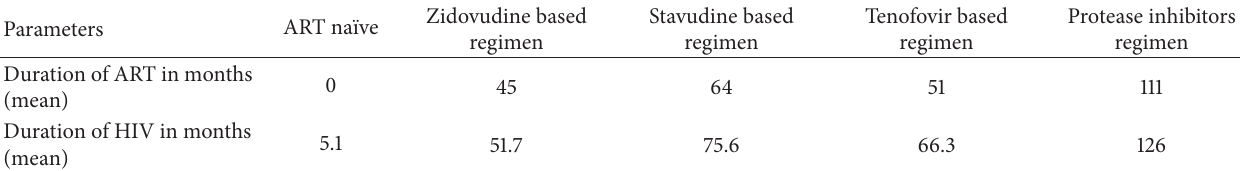
Table 1: Duration of HIV infection and duration of ART in different study population.